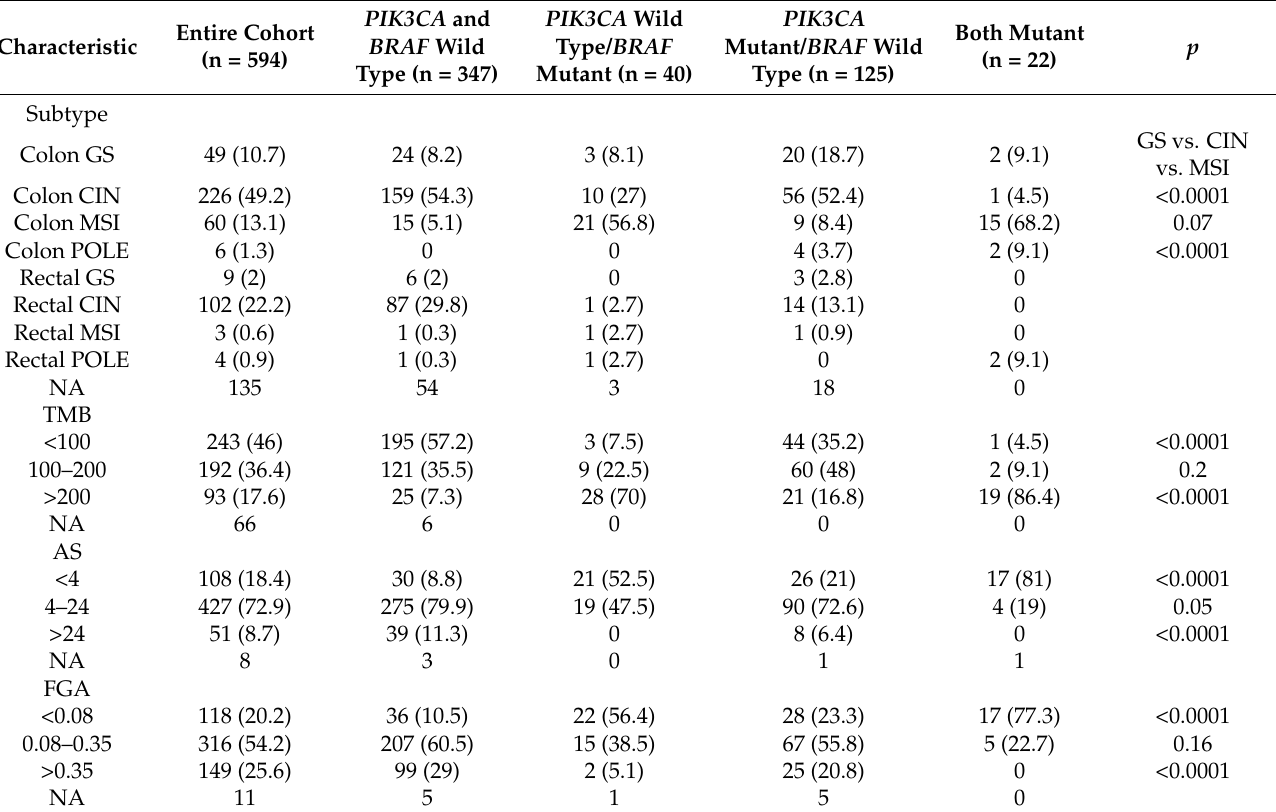
Table 3. Prevalence of cases according to Tumor Mutation Burden (TMB), Aneuploidy Score (AS), and Fraction Genome Altered (FGA) in the groups with or without BRAF and PIK3CA mutations in TCGA. Analysis for PIK3CA and BRAF mutations was performed in 534 samples. GS: Genomic Stable; CIN: Chromosomal Instability; MSI: Microsatellite Instability; NA: not available. The p values presented in the last column refer to the χ 2 test. For each categorical characteristic, three comparisons are presented. The first comparison includes all four groups (group with both PIK3CA and BRAF wild type, group with PIK3CA wild type and BRAF mutant, group with PIK3CA mutant and BRAF wild type, and group with both PIK3CA and BRAF mutant), the second comparison is between double mutant cancers and cancers with BRAF mutations and wild type PIK3CA . The third comparison is between double mutant cancers and cancers with PIK3CA mutated and BRAF wild type.